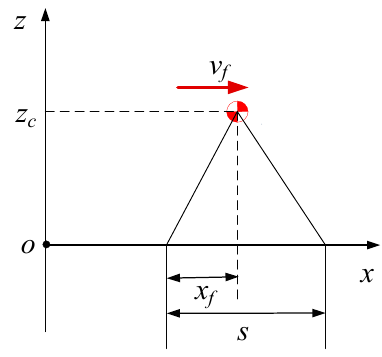
Figure 11. State of a support leg exchange.